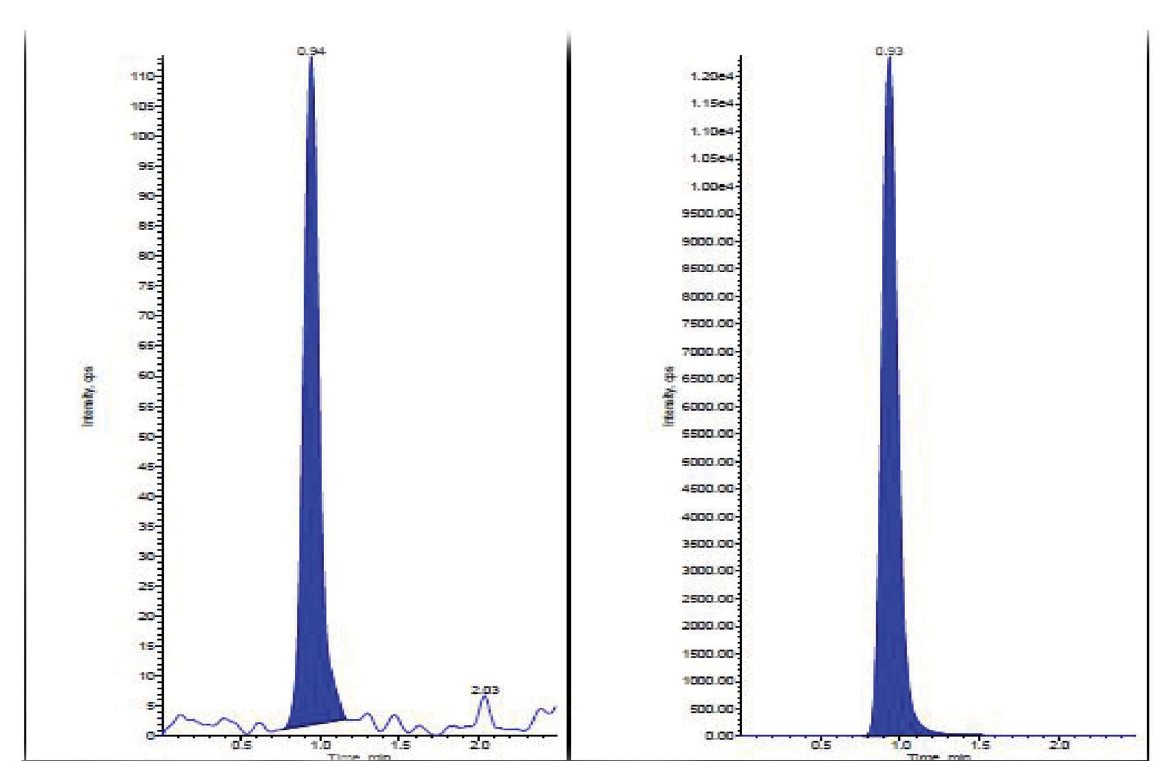
FIGURE 6 - Chromatogram of cabozantinib and cabozantinib-d4 at LOQ